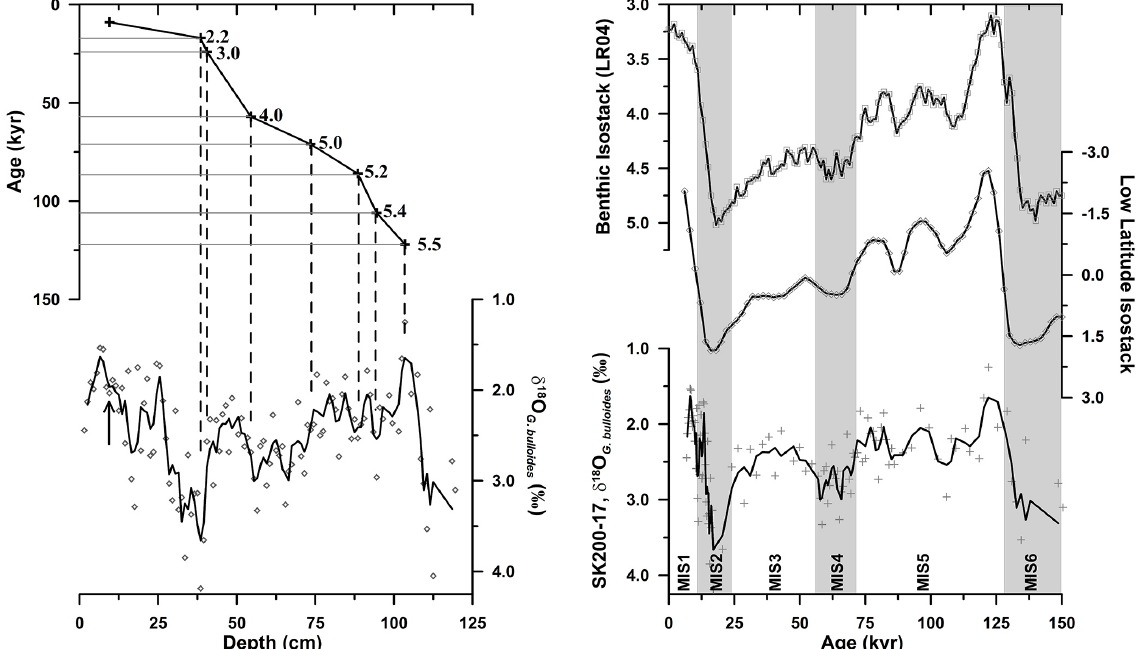
Fig. 2. The chronology of the core, as established by comparing the δ 18 O Globigerina bulloides in the core with low latitude isostack map of Bassinot et al. (1994). This isostack curve was chosen as it is based on planktic foraminifera. The solid line represents three-point running average. The tie point isotopic events are marked by dashed and light lines as well as the numbers. The single AMS date at 9–10cm depth interval is marked by an arrow. The final chronology of core SK 200/17 is compared with both the low-latitude isostack of Bassinot et al. (1994), as well as the benthic foraminiferal isostack (LR04) of Lisiecki and Raymo